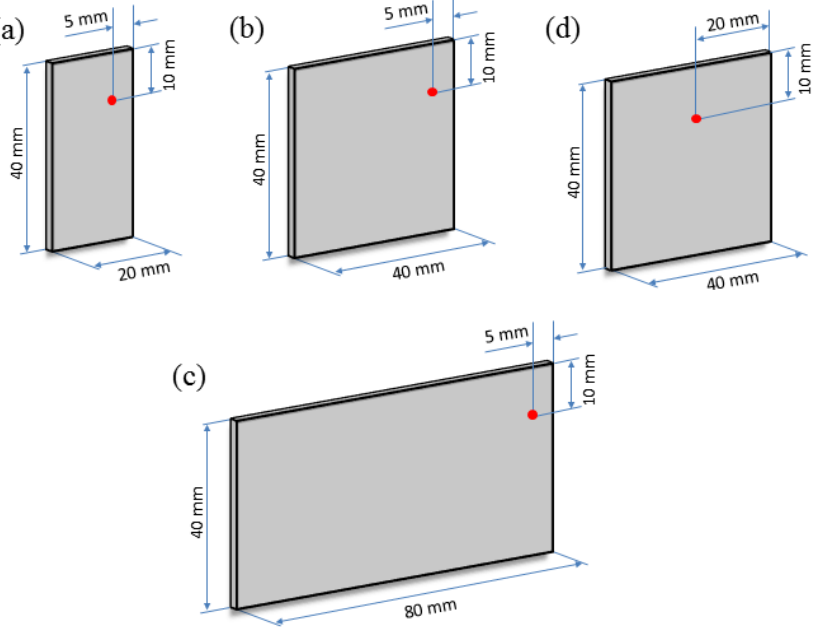
Figure 4. Schematic of deposited thin-wall sample size and measured points position: ( a ) sample 1 (20 mm × 40 mm × 1 mm and measuring near the end), ( b ) sample 2 (40 mm × 40 mm × 1 mm and measuring near the end), ( c ) sample 3 (80 mm × 40 mm × 1 mm and measuring near the end), ( d ) sample 4 (40 mm × mm × 1 mm and measuring in the middle).